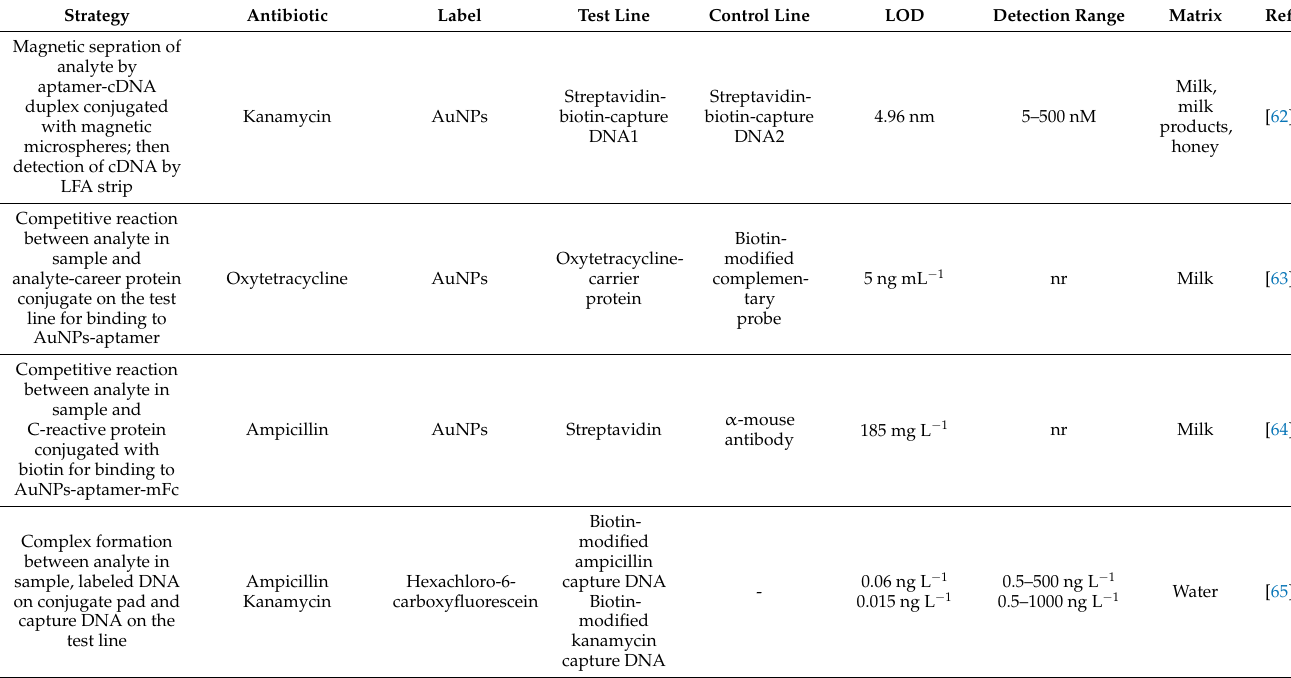
Table 4. Aptamer-based lateral flow assays for detection of